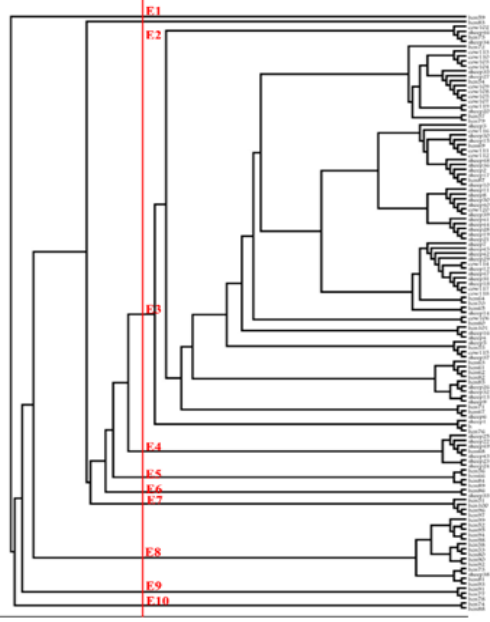
Fig 1. Dendrogram Relating to Isolated Strains of Escherichia coli